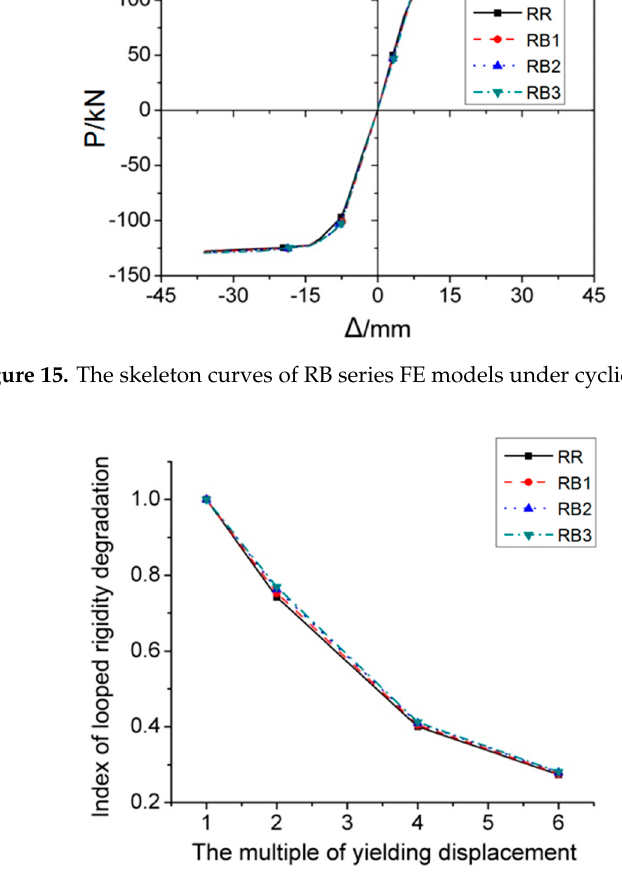
Figure 16 . Index of looped rigidity degradation curves of RB series joints.